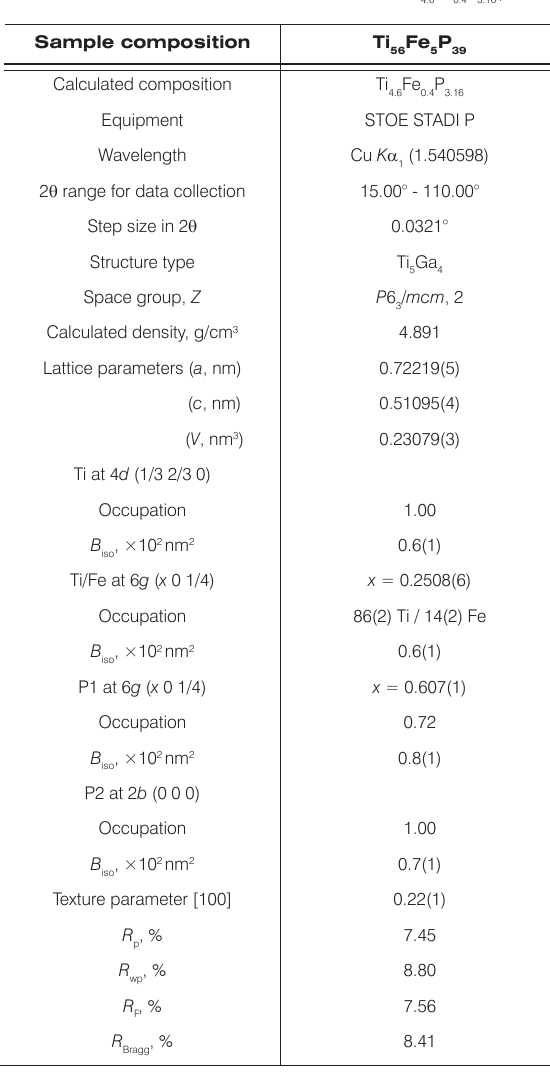
Fe P . The hkl indices are indicated. 4.6 0.4 3.16 Table 2. Results of structure refinements for the Ti